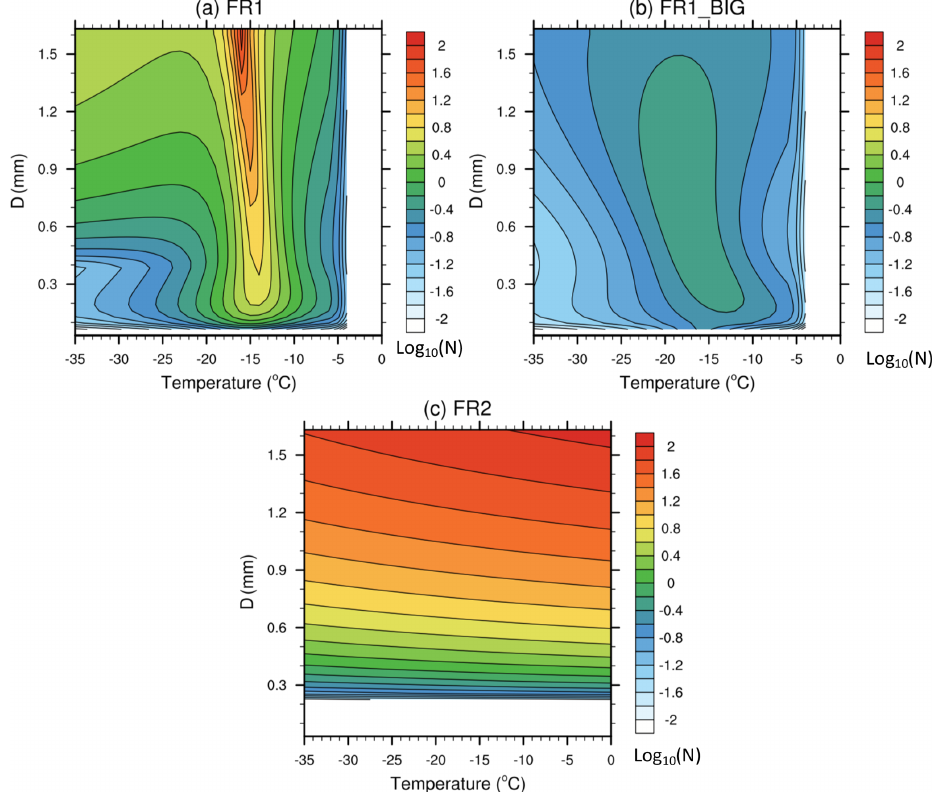
Figure 2. The number of fragments per frozen drop (shown as log 10 N ) as a function of temperature and particle diameter, from (a) mode 1 of the rain freezing fragmentation (FR1), (b) mode 1 of the rain freezing fragmentation but for the big fragments (FR1_BIG), and (c) mode 2 of the rain freezing fragmentation